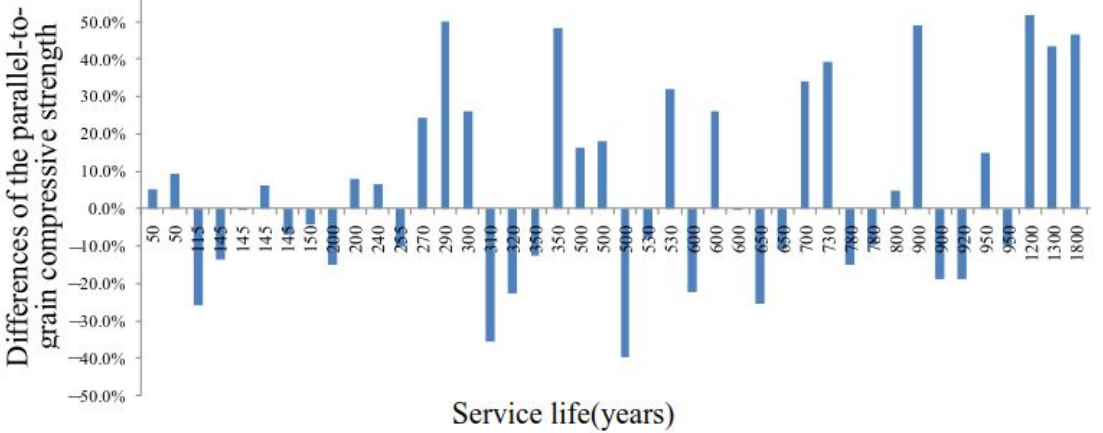
Figure 1. The parallel ‐ to ‐ grain compressive strengths of aged timber.